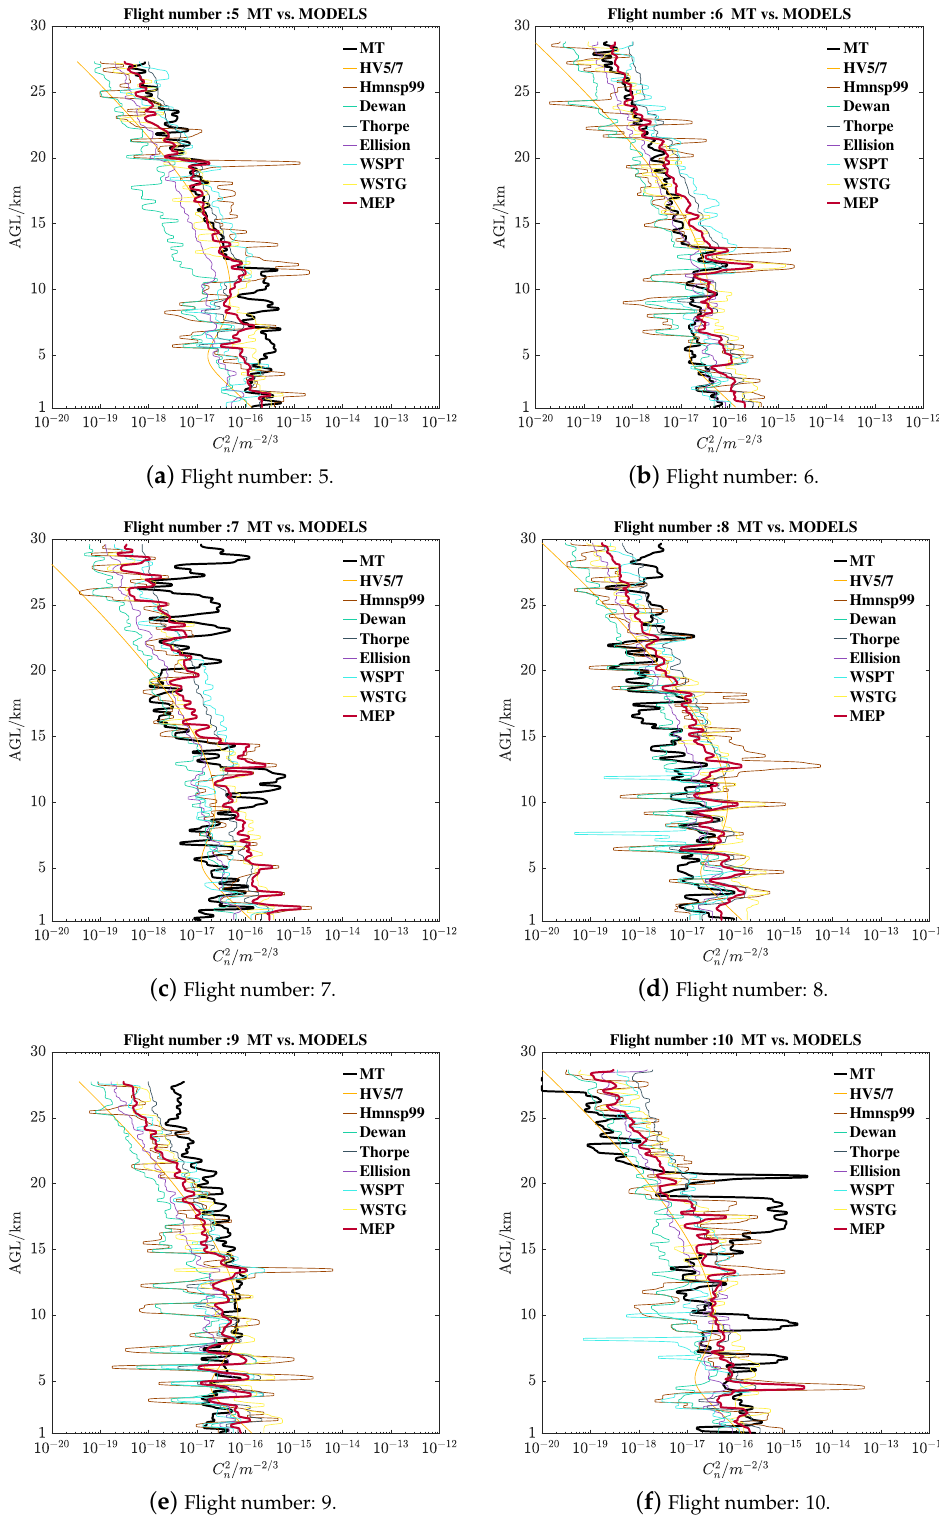
Figure A5. The refractive index structure parameter profiles of MT and estimations in NCACN: Figure A5 sub-figures ( a – f ) are flight numbers 5–10 in Table